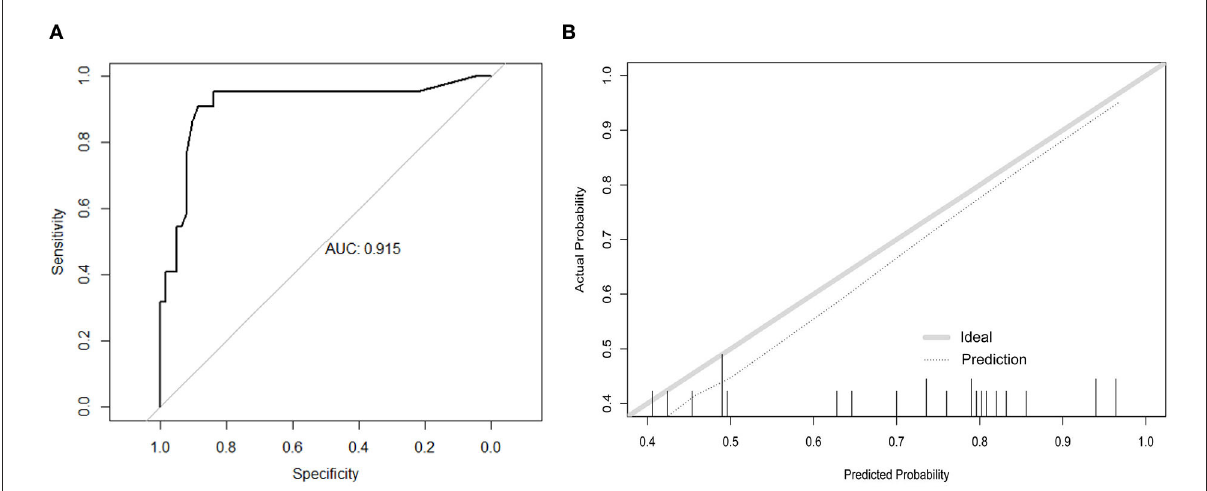
FIGURE3 Discrimination performance and predictive consistency of tools for predicting death in the external validation. (A) ROC curve and AUC of the tool for predicting probability of death; (B) calibration curves of the tool predicting probability of death. The dotted line represents a perfect prediction by an ideal model and the solid line represents the performance of the nomogram in the validation. A closer fit of the lines represents a better prediction. ROC, receiver operating characteristic; AUC, area under curve; ICU, intensive care